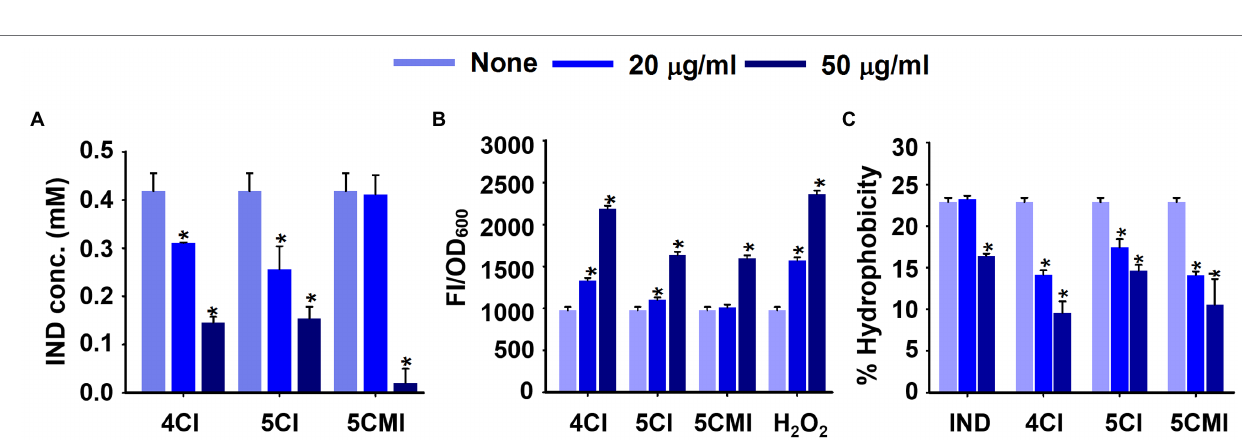
FIGURE 5 | (A) Extracellular indole concentrations of UPEC in the presence of indole derivatives, (B) intracellular ROS production levels in UPEC in the presence of indoles or the positive control H 2 O 2 , and (C) Cell surface hydrophobicities of UPEC in the presence of indoles. * p < 0.05 vs. non-treated